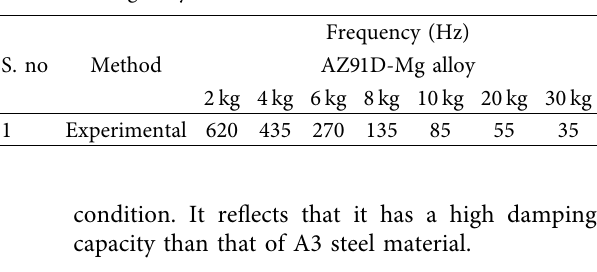
Table 12: Frequency under loading condition in experimental method for Mg